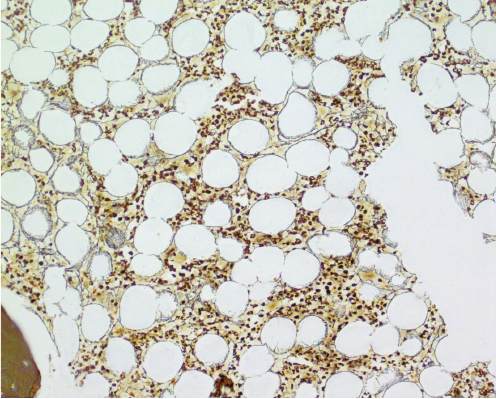
Figure 7: no increase in reticulin fibrosis, bone marrow trephine reticulin stain × 200.